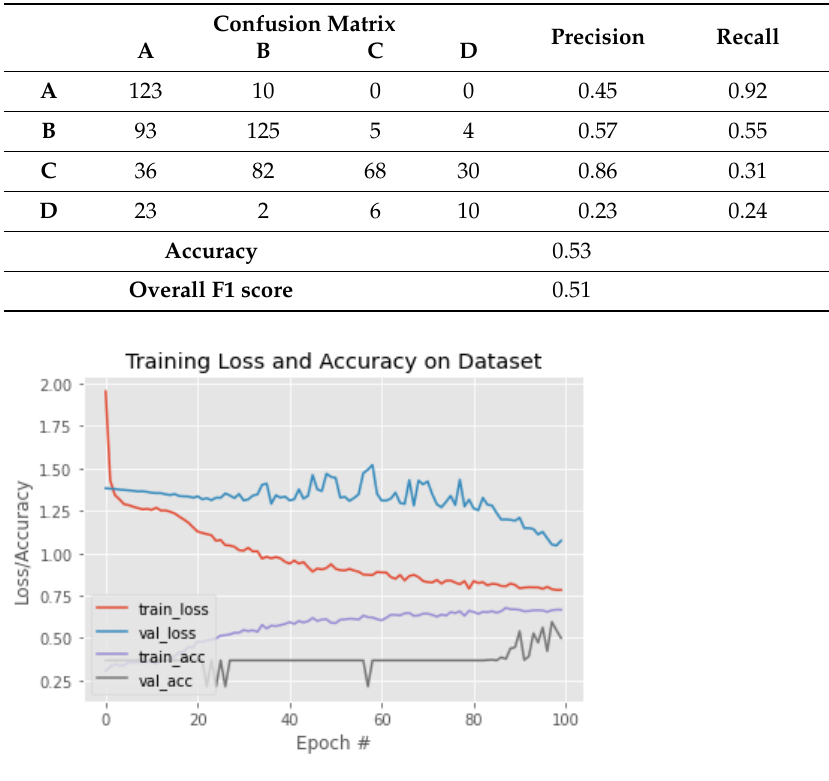
Figure 12. The training behavior of the model based on